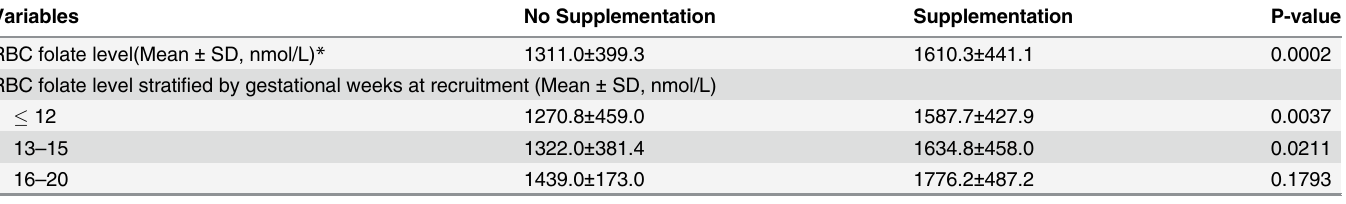
Table 3. RBC folate levels in participants with folic acid supplementation versus those without, by gestational age at recruitment OaK Birth Cohort Study, October 2002 to December 2008.